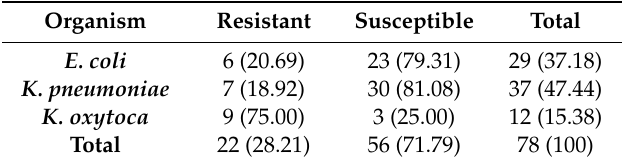
Table 4. Carbapenem susceptibility of the Enterobacteriaceae